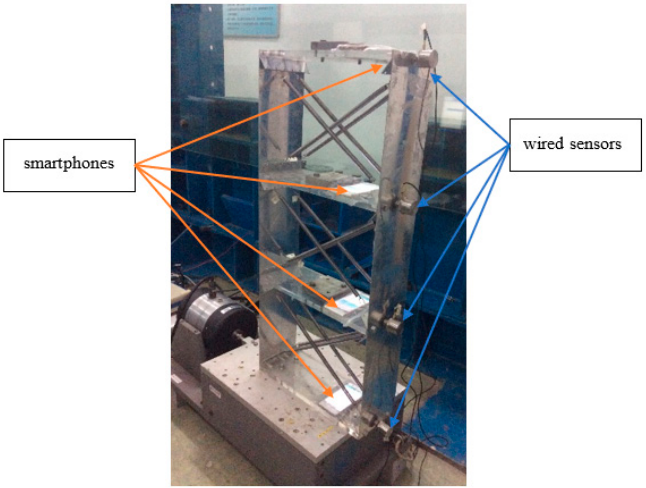
Figure 20. Setup of shake table test. Table 5. Floor mass and story stiffness of test structure.